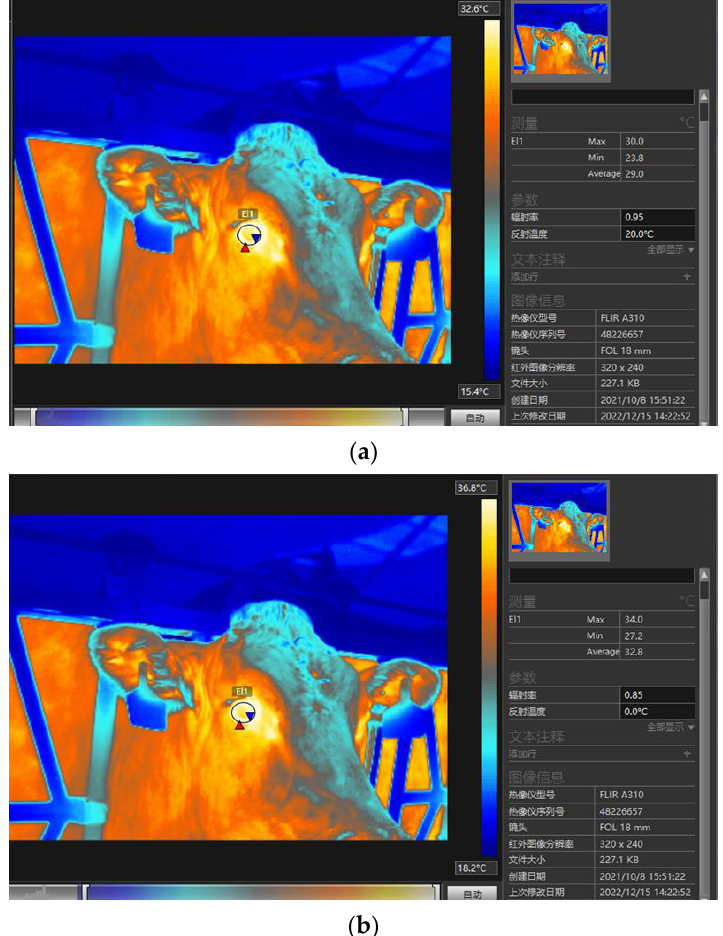
Figure 5. Comparison before and after thermal infrared image correction. ( a ) Max: 30.0 ℃ , min: 23.8 ℃ , average: 29.0 ℃ , with thermal infrared image parameters before temperature and humidity correction. ( b ) Max: 34.0 ℃ , min: 27.2 ℃ , average: 32.8 ℃ , with thermal infrared image parameters after temperature and humidity correction. “ 测量 ” means Measurement; “ 参数 ” means Parameters ; “ 辐射率 ” means Irradiance; “ 反射温度 ” means Reflection temperature; “ 全部显示 ” means Show all; “ 文本注释 ” means Text notes; “ 添加行 ” means Add lines; “ 图像信息 ” means Image information; “ 热像仪型号 ” means Thermal imager model; “ 热像仪序列号 ” means Serial number of thermal imager; “ 镜头 ” means Lens parameter; “ 红外图像分辨率 ” means Infrared image resolution; “ 文件大小 ” means File size; “ 创建日期 ” means Creation date; “ 上次修改时间 ” means Last modification time. “ 自动 ” means Auto .